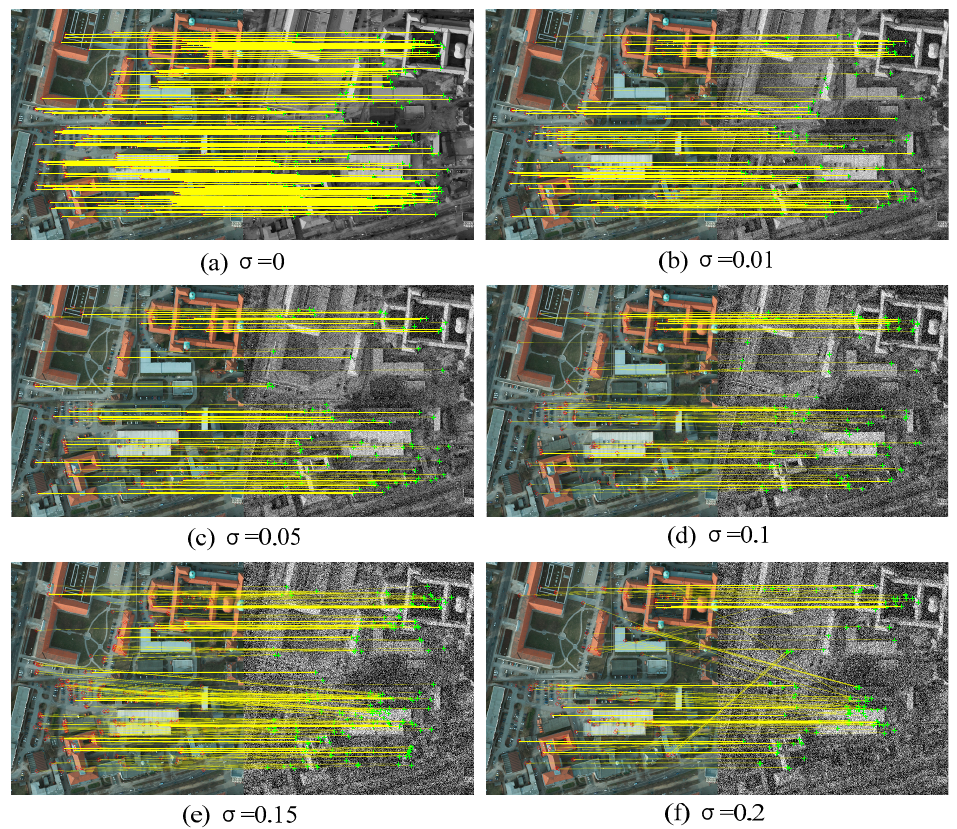
Figure 11. Qualitative comparisons of feature matching on Potsdam (VIS/NIR) dataset at different Gaussian white noise levels. σ is the variance of Gaussian function, and large variance σ indicates great noise intensity.